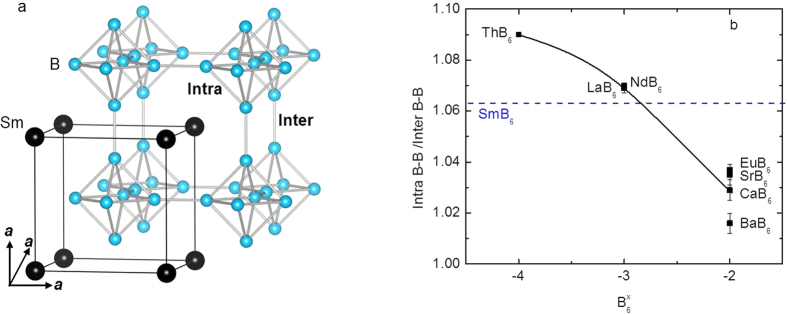
(a) Structural depiction of SmB6. (b) The intra boron-boron bond distances normalized by the inter boron-boron distances (Intra B-B/Inter B-B) of the B6 octahedral cluster for selected hexaborides versus different charges of the B6 cluster (B6x) (■). Also shown is the Intra B-B/Inter B-B for all SmB6
FZ cuts and the FG SmB6 sample (blue dashed line). The charge on the B6 cluster for SmB6 mostly closely resembles −3, but is slight reduced, consistent with a partial mixed valency. The curved solid line serves as a guide to the eye.